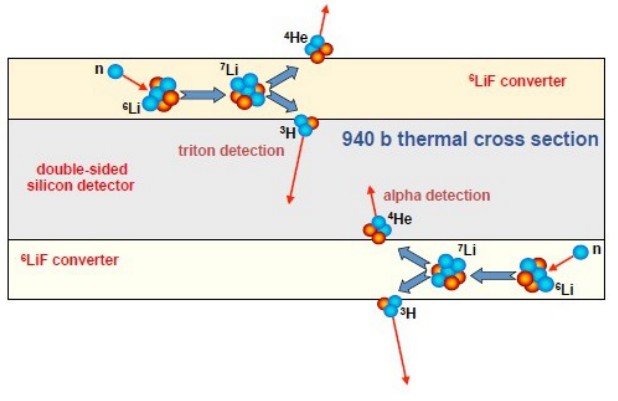
Fig. 1. The SiLiF scheme neutron detection.